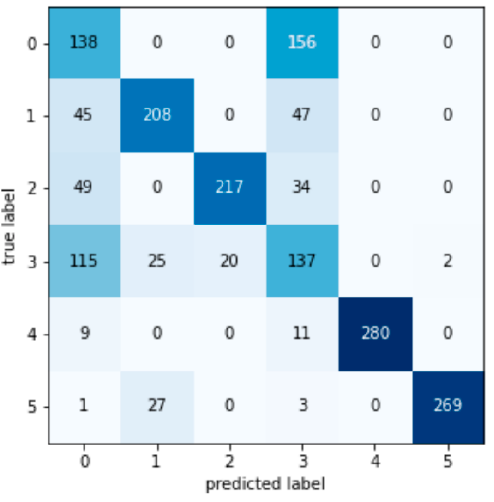
Figure A6. Bayesian confusion